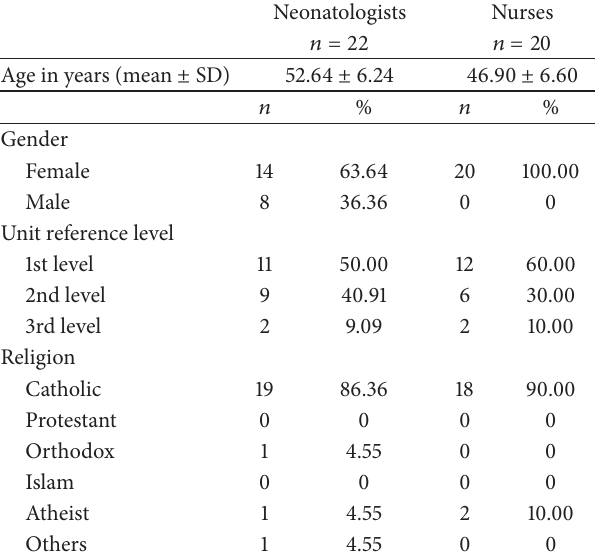
Table 1: Social and demographic characteristics of